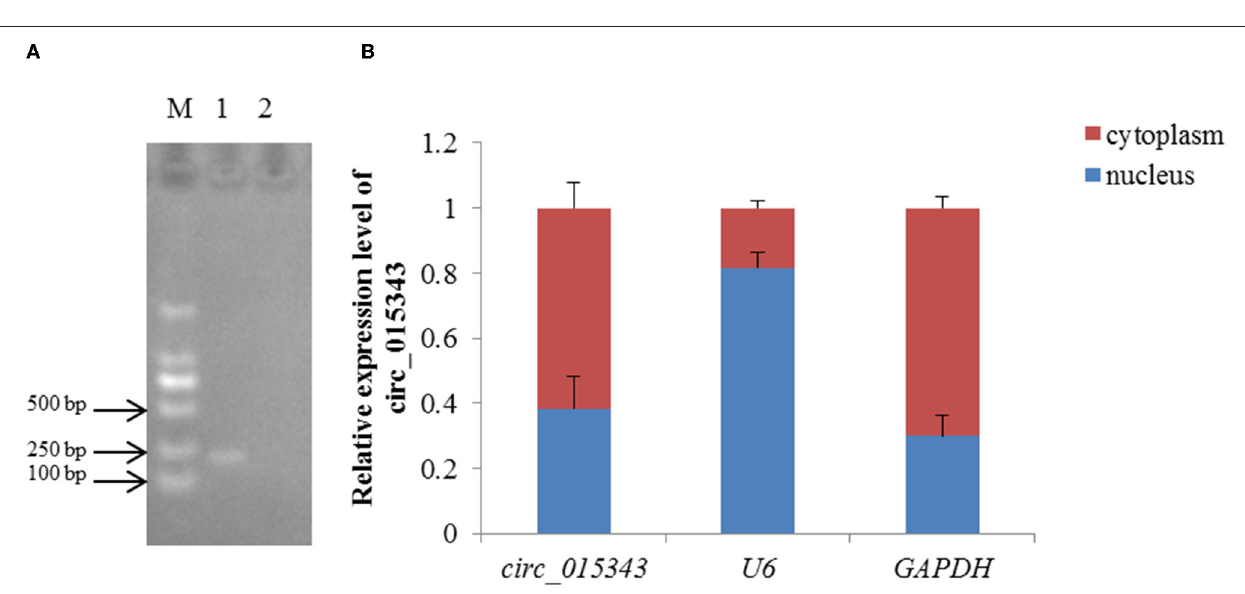
expressed in the cytoplasm, but was only weakly expressed or did not express in the nucleus of ovine mammary epithelial cells ( Figure 2A ). The relative expression levels of circ_015343 in the cytoplasm and nucleus were further detected by using RT-qPCR,